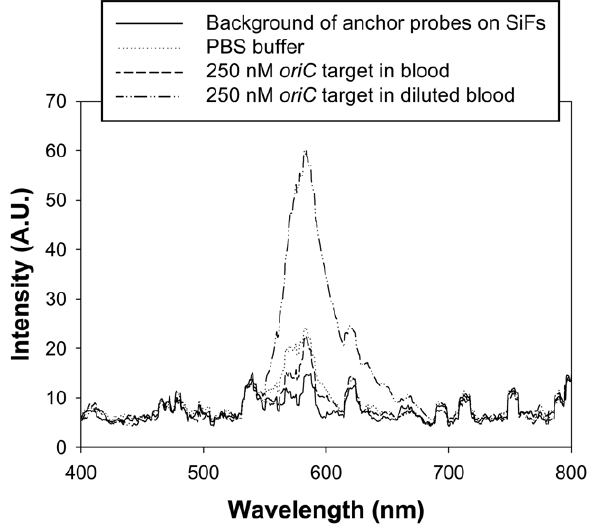
Figure 5. MAMEF-based detection of a synthetic oriC oligonu- cleotide suspended in whole human blood. Whole human blood was spiked with the oriC oligonucleotide (250 nM) and tested by MAMEF or diluted 1:1 with PBS and then tested by MAMEF.